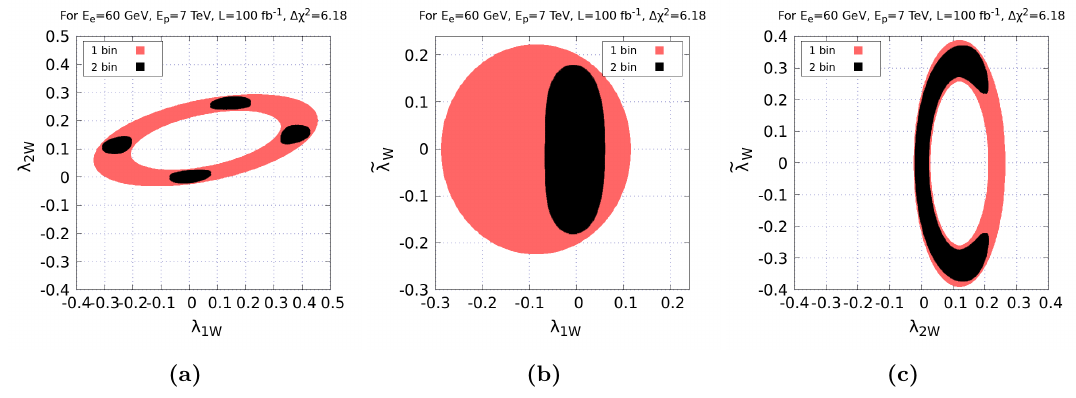
Figure 8 . Two-dimensional parameter space for HWW BSM parameters at L = 100 fb − 1 using cross section (red) and ∆ φ distribution (black) as observables.